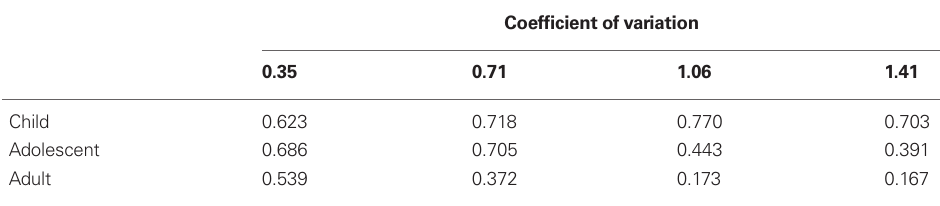
Table 1 | Proportion risky choices by age group and coefficient of